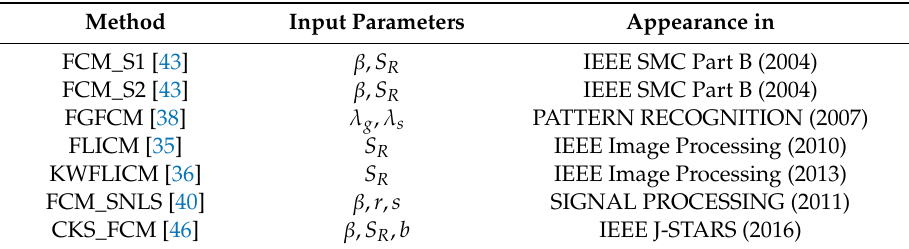
Figure 7. Object function values of FCM_NNS with different number of iterations.